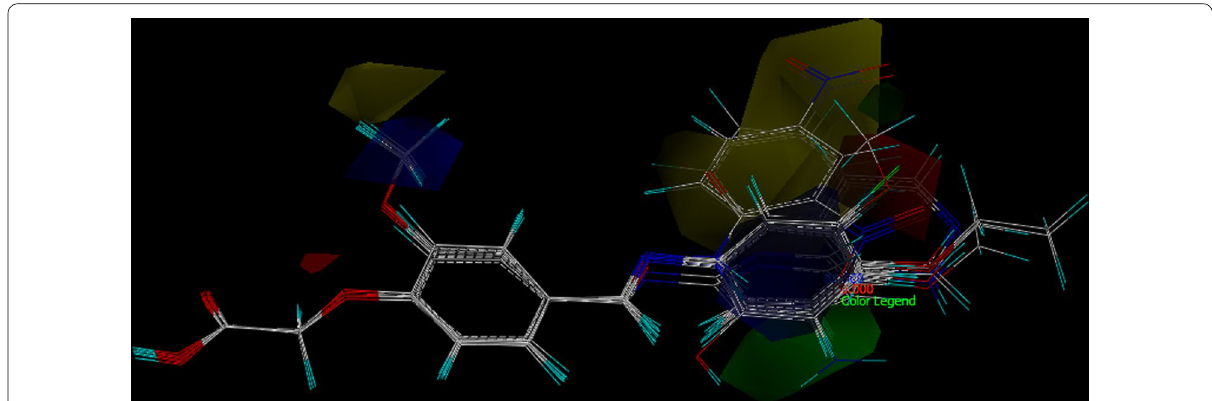
Fig. 9 CoMSIA steric and electrostatic SD x coefficient contour plot; green contours indicate regions where steric bulk is favorable and yellow contours indicate regions where steric bulk is disfavored. Whereas Blue contours indicate regions where electronegative groups increase activity and red contours indicate regions where electropositive groups increase activity